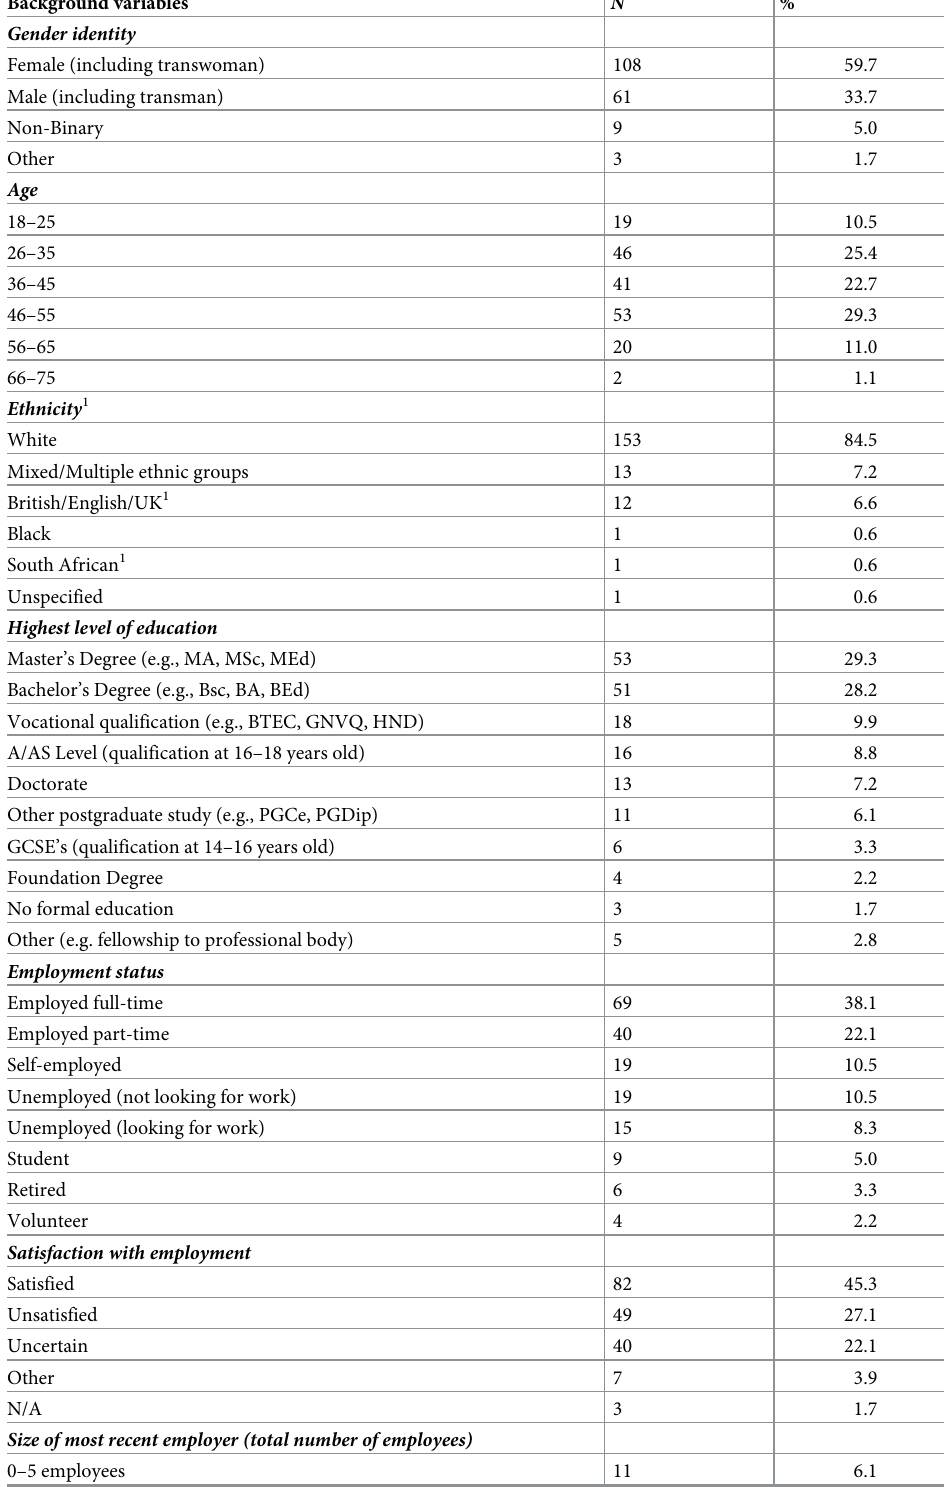
Table 1. Participants demographic information ( n =